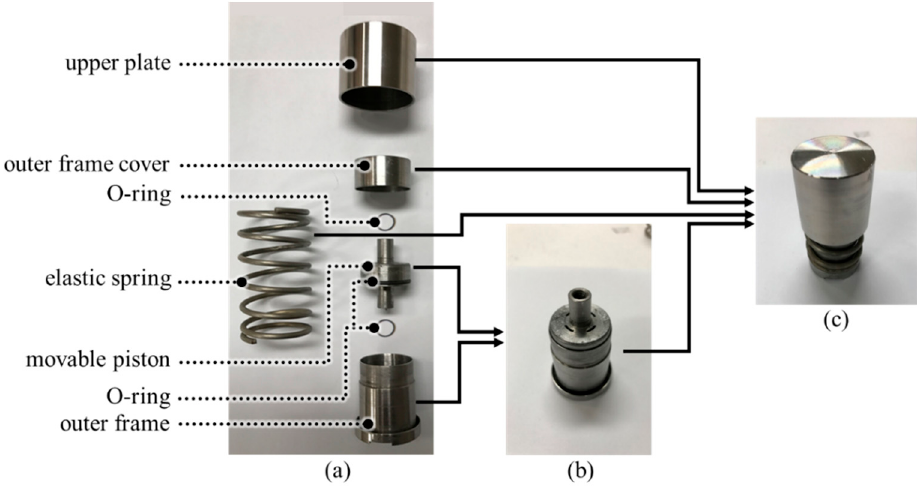
Figure 10. Fabrication process of the proposed MR haptic actuator: ( a ) Exploded view of the proposed MR haptic actuator; ( b ) Combined movable piston with outer frame; ( c ) Fabricated MR haptic actuator.